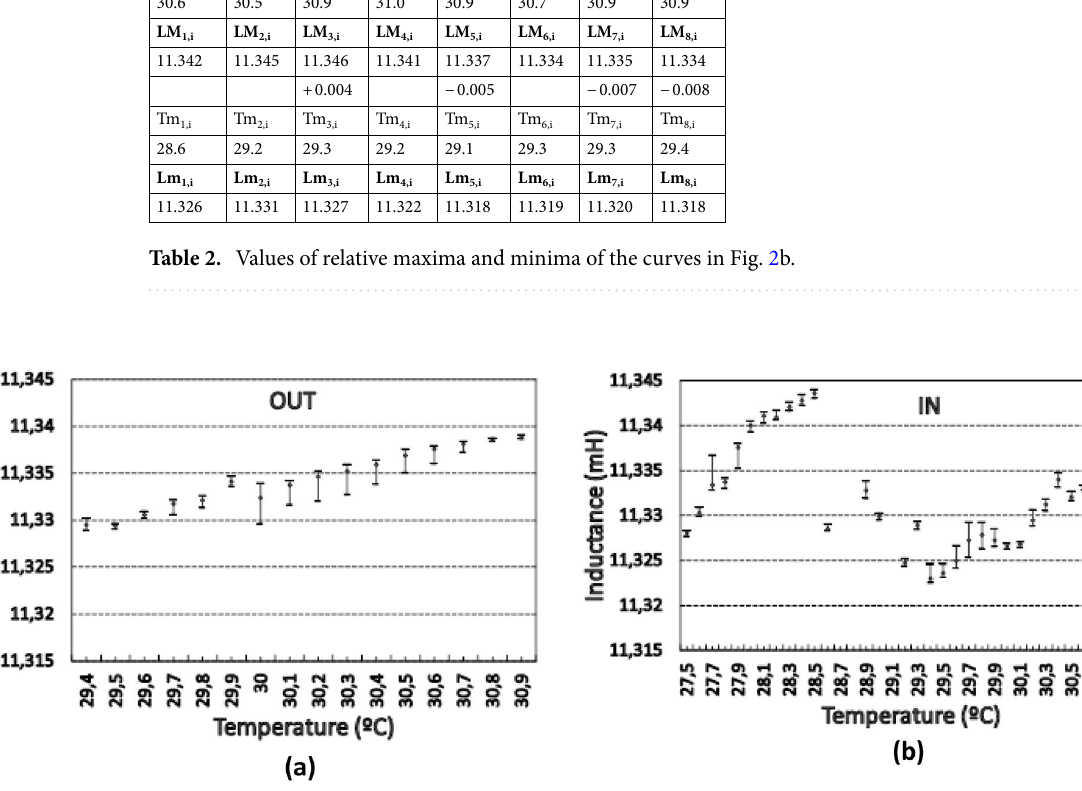
Figure. 3. Inductance temperature coefficient. ( a ) Outside the box. ( b ) Inside the box. The increase from 27.5 to 28.5 °C took place during the days 4th and 5th of November